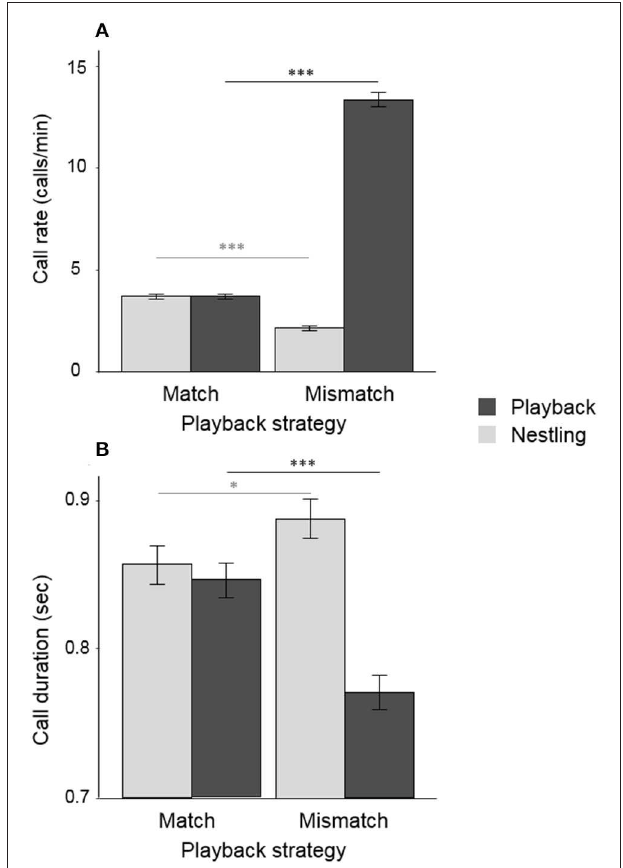
FIGURE 2 | Mean call duration (A) and mean call rate (B) of nestlings and playback adopting the matching and mismatching strategies. The error bars represent the standard errors. Asterisks indicate significant differences between groups (* P < 0.05; *** P < 0.001), calculated from the models reported in Table 1 . Each playback strategy was repeated for four 15-min periods, randomly ordered across the